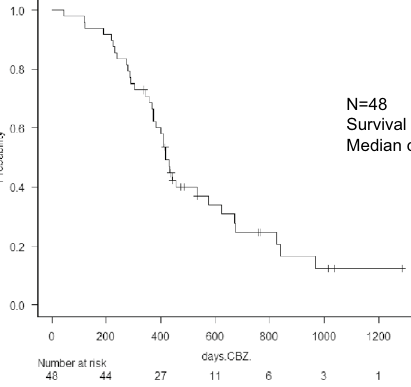
Figure 1. Kaplan–Meier curve of overall survival (OS) rate of all patients with CRPC after four or more cycles of cabazitaxel treatment. Survival rate at median observation period [95% CI]; 0.686 [0.534–0.798]. Median overall survival (days) [95% CI]; 418 [372–575], N = 48. CBZ, cabazitaxel; CI, confidence interval; CRPC, castration-resistant prostate cancer; OS, overall